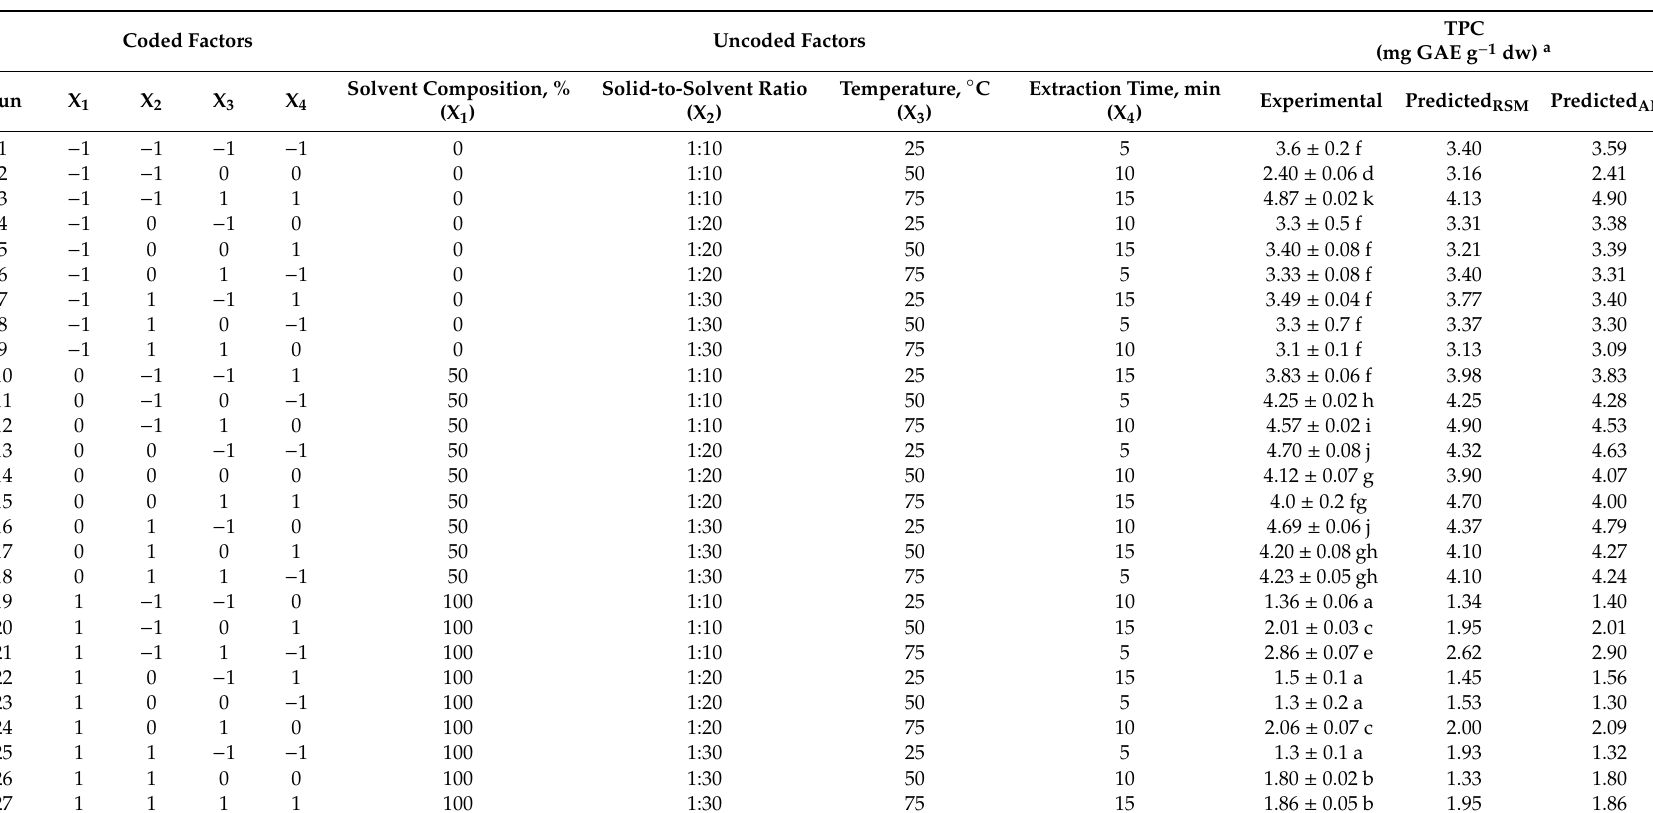
Table 1. Fractional factorial design with coded and uncoded parameters of microwave-assisted extraction (MAE), and experimental and predicted response values (Total Phenolic Content, TPC) in the obtained extracts using response surface methodology (RSM) and artificial neural network (ANN). Coded